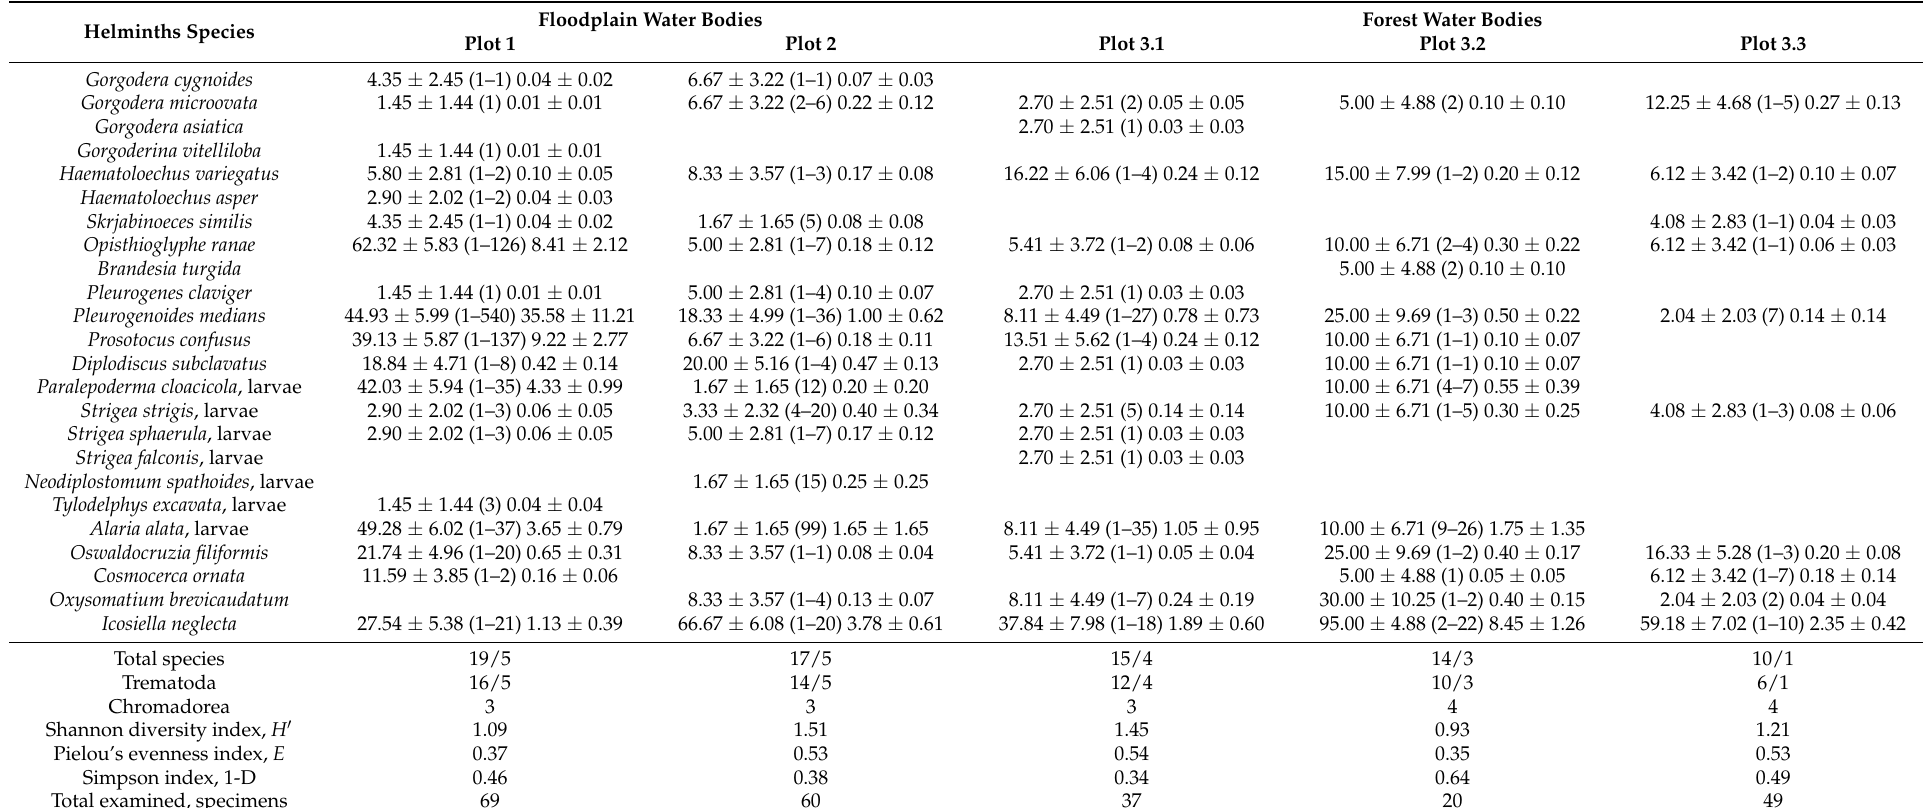
Table 1. Helminths of Pelophylax lessonae in different water